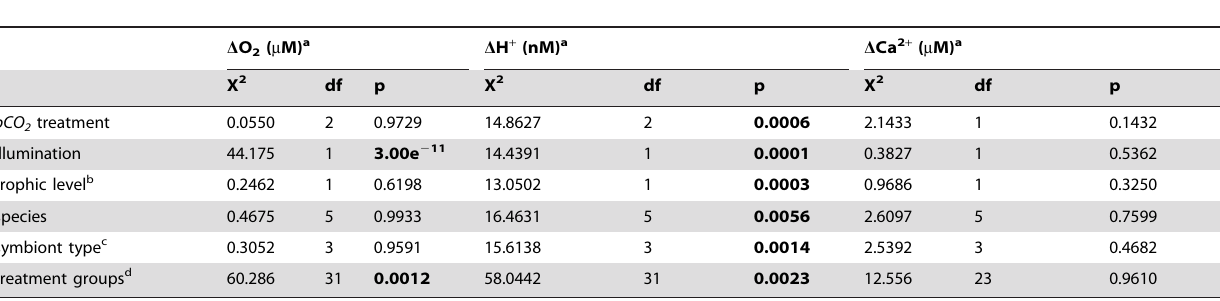
Table 2. Omnibus Kruskal-Wallis one way analysis of variance results of mean (n= 2–4) D O 2 , D H + and D Ca 2 + measured during three pCO 2 treatment incubations (432, 1141, 2151 m atm) for different